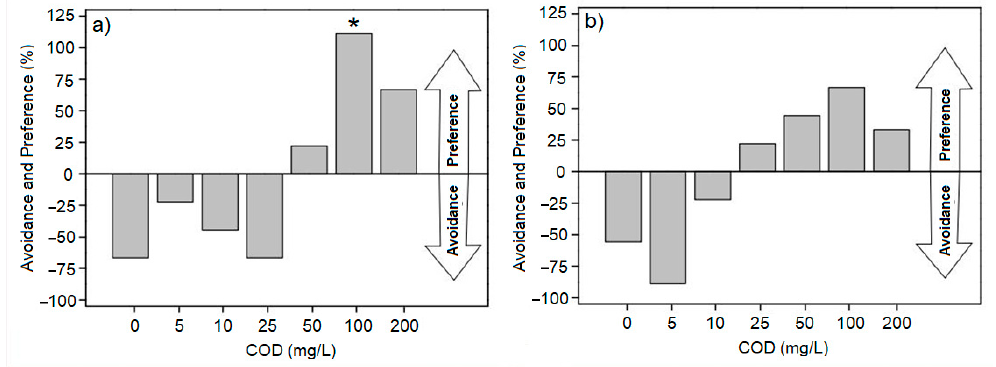
Figure 4. Preference and avoidance responses (%) of zebrafish exposed to treated synthetic water from the cassava starch industry: ( a ) after 4 h of exposition, and ( b ) after 6 h of exposition. Data were pooled from 3 replicates; therefore, the standard deviation is not presented. Asterisks represent statistically significant differences ( p < 0.05) in the distribution of organisms when compared with the distribution in control (Fisher’s exact test (2 × 2); see Tables S9 and S10 in Supplementary Material). Changes in the distribution of organisms per compartment could be related to the content of total cyanide in water. The relation of the distribution of organisms per compart- ment and the content of total cyanide for the assays with untreated and treated synthetic waters from the cassava starch industry is depicted in the plots of Figure 5. Certainly, the removal of cyanide seems to have a strong influence on the preference of zebrafish.